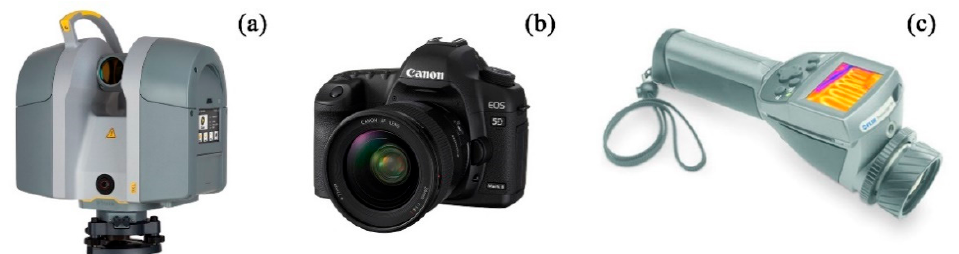
Figure 3. ( a ) Trimble TX6 laser scanner; ( b ) Canon EOS 5D Mark II; ( c ) FLIR ThermaCAM TM B4.